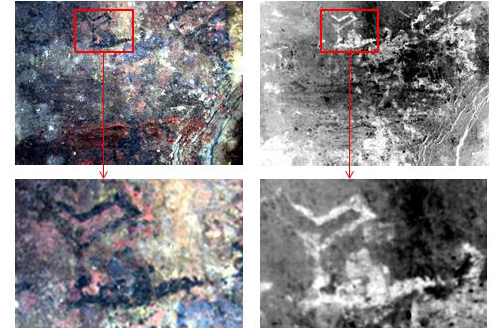
Figure6. Comparison of PCA before and after